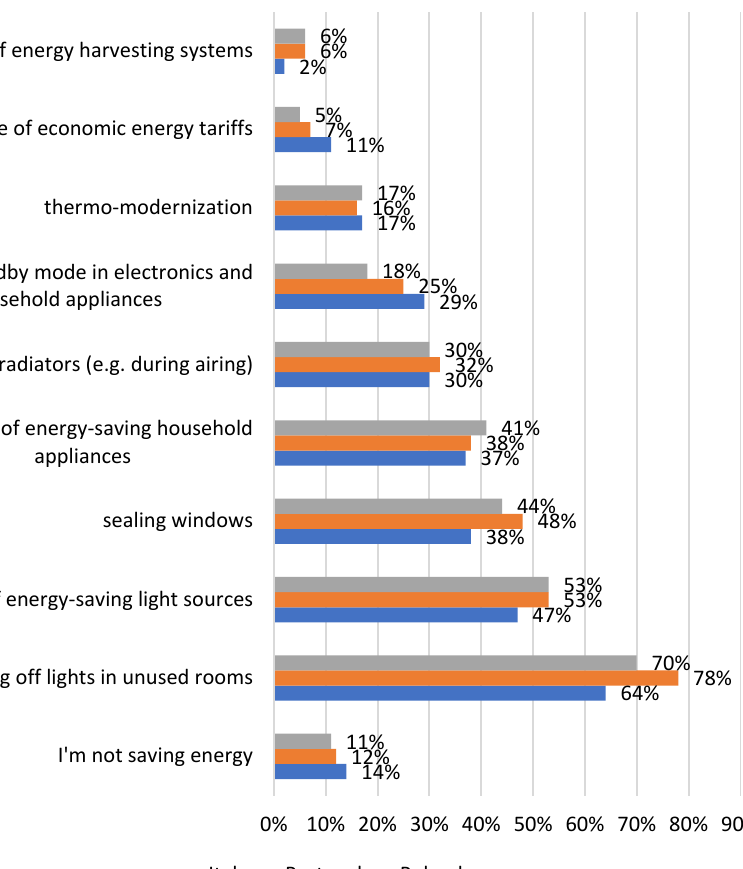
Figure 2. Energy saving methods.